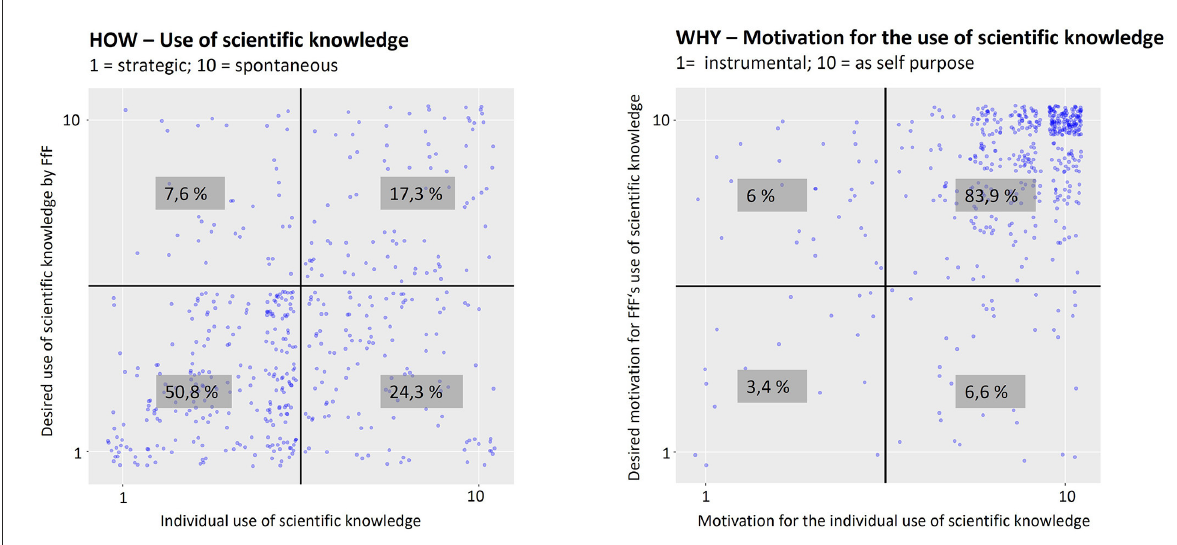
FIGURE3 Use and motivation for the use of scientific knowledge by Fridays for Future activists on the movement and individual level.